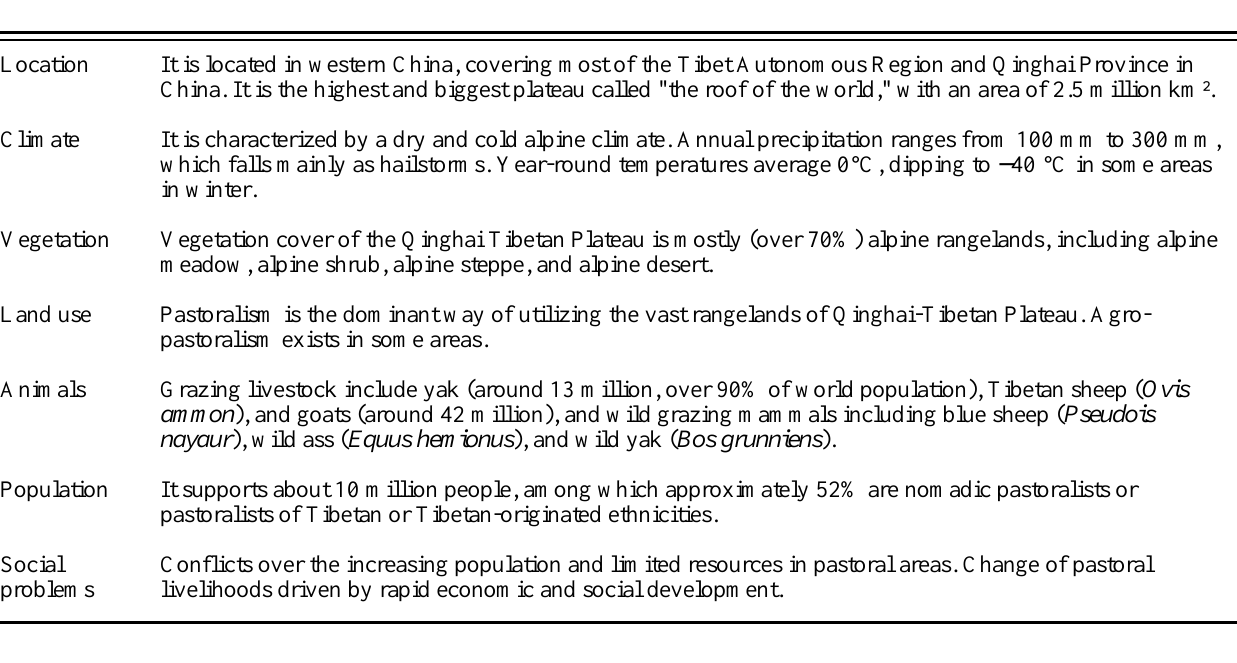
Table 3. General information on pastoralism on the Qinghai-Tibetan Plateau (Long et al. 1999, Dong et al.